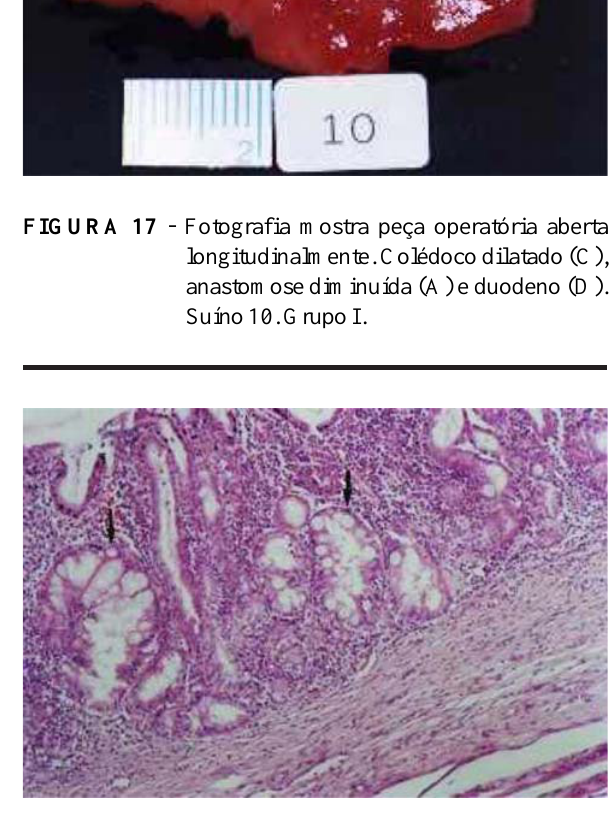
FIGURA 18 - Fotomicrografia da região da papila mostrando FIGURA 19 - Fotomicrografia mostra glândulas do tipo a mucosa duodenal (seta 1) continuando com intestinal (metaplasia intetinal) no a mucosa do colédoco (seta 2). Grupo III.